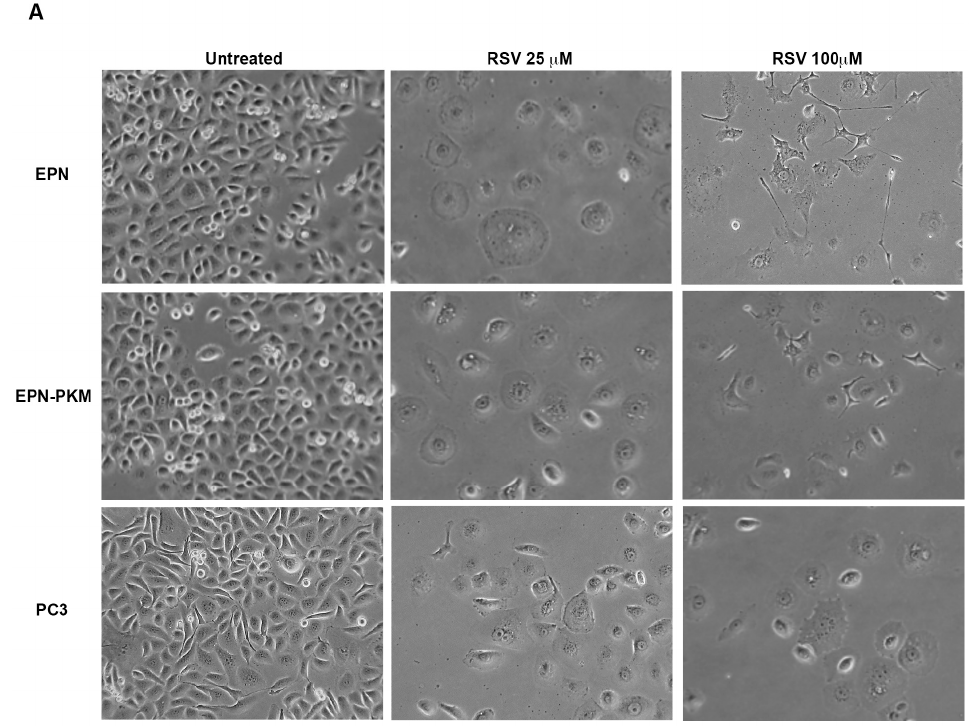
Figure 3. RSV induces growth arrest in EPN, EPN-PKM and PC3 cells: ( A ) RSV (25, 50 and 100 μ M) was added 24 h after seeding 1 × 10 5 EPN, EPN-PKM and PC3 cells in standard medium. Cell number was determined in a Neubauer hemocytometer at the indicated time points. Data are mean ± SD of a representative experiment performed in triplicate. The differences between treated and untreated cells are statistically significant ( p < 0.05) for any tested concentration of RSV at any experimental time. (*) indicates statistically significant differences ( p < 0.05) between cells treated with 25 μ M RSV and those treated with 100 μ M RSV; ( B ) Total cell lysates from EPN, EPN-PKM and PC3 cells in control conditions and treated with 25 and 100 μ M RSV for 24 h were analyzed by Western blot using the indicated antibodies. GAPDH was used as loading control.